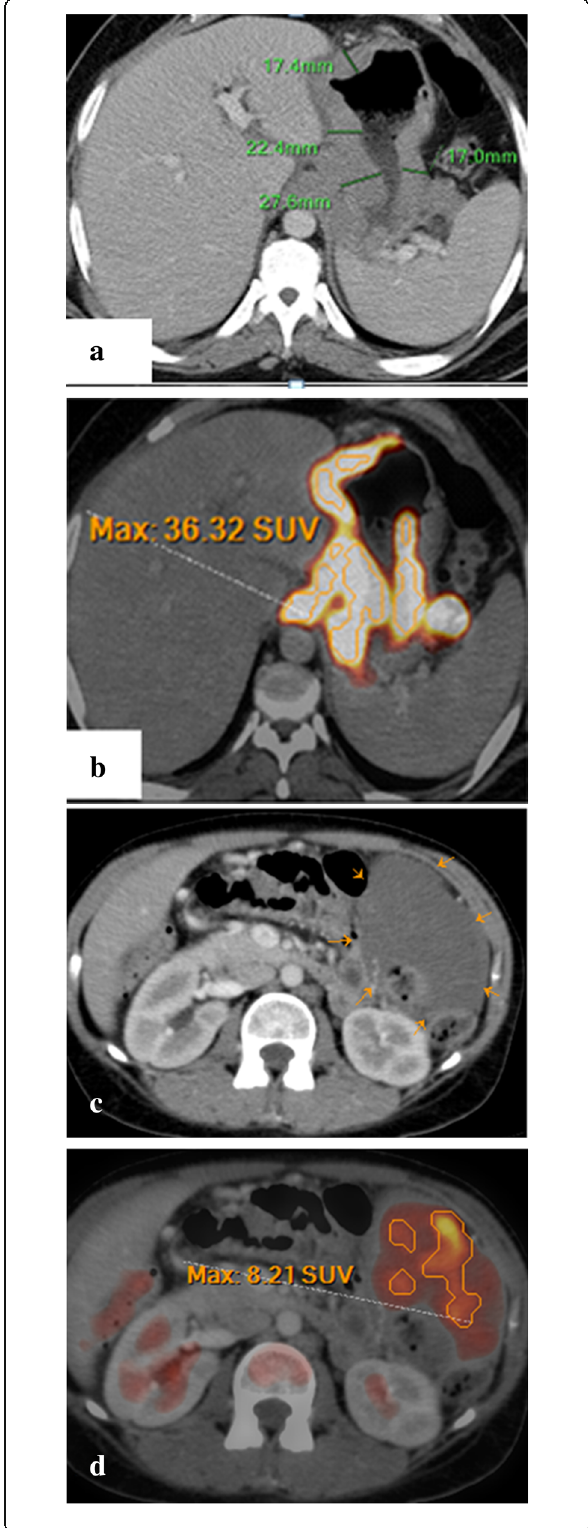
Fig. 6 a – d GIT lymphoma. a , b Gastric lymphoma: non-uniform soft tissue mural thickening of the gastric walls more pronounced at the lesser curvature. In PET CT images, b it is intensely avid, associated with small perigastric and gastrohepatic LNs having the same activity. c , d Peritoneal lymphoma: a large metabolically active left hypochondrial peritoneal soft tissue lesion [orange arrows ] encasing the bowel anteriorly, the spleen and tail of pancreas posteriorly(not shown) (proven to be B cell